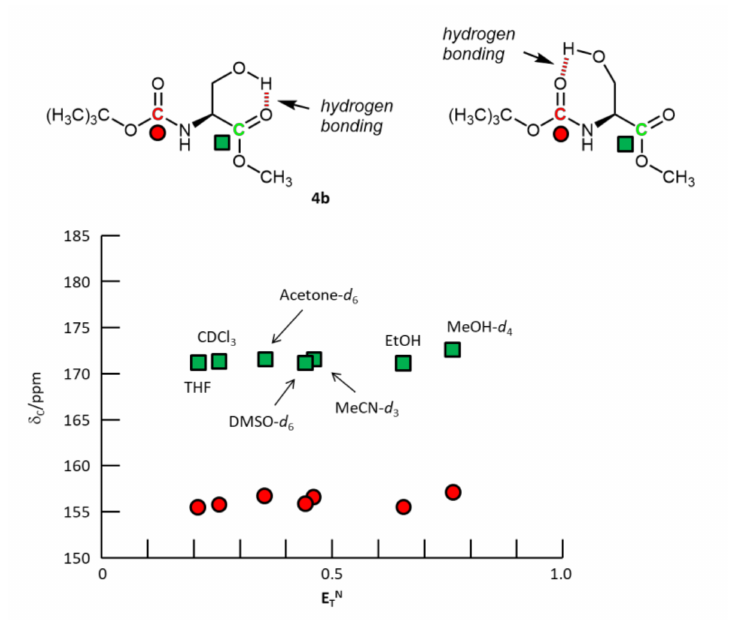
Figure 8. 13 C NMR chemical shifts of the carbonyl carbons of N -Boc-L-serine-OMe 4b .